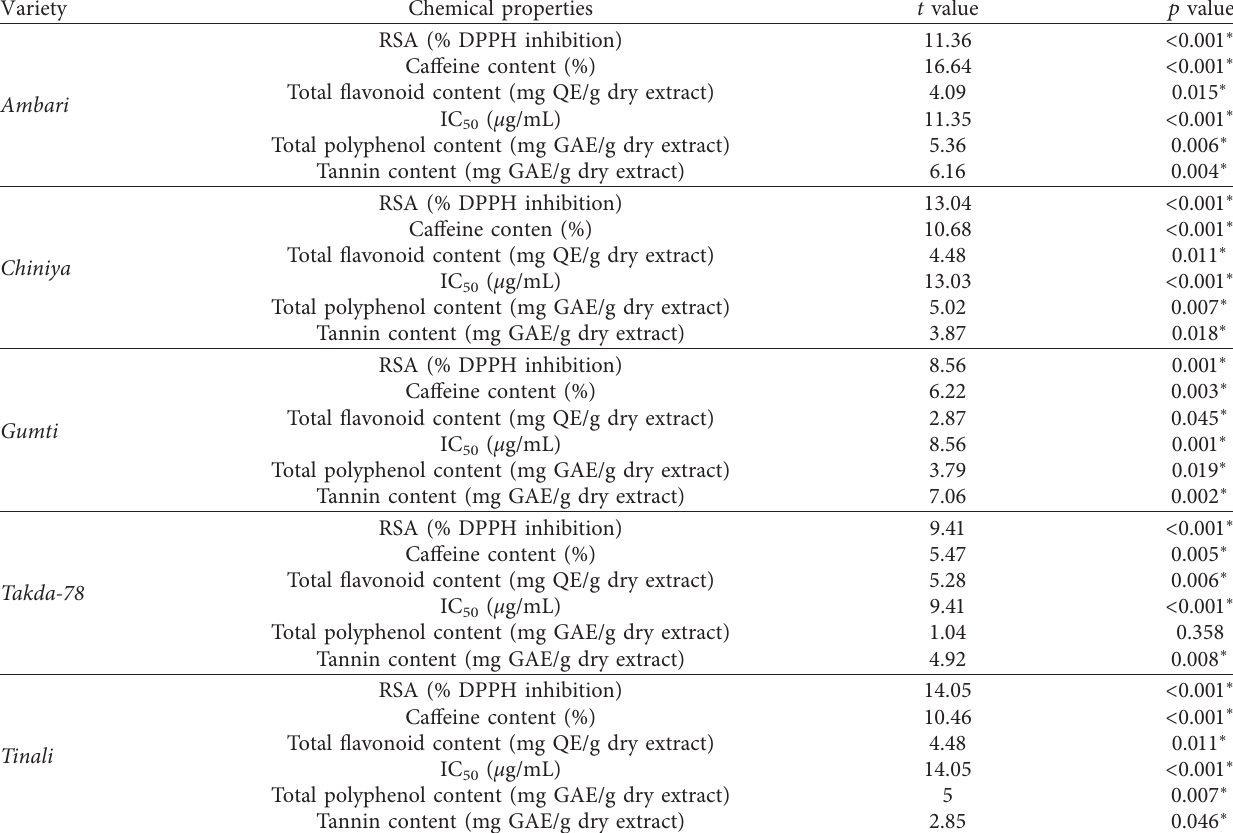
Table 3: t -test for the chemical properties of green and black tea from different clones of tea plants.